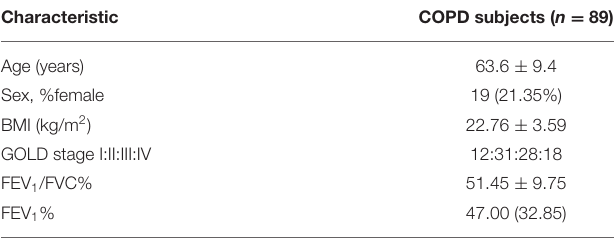
TABLE 1 | Patient Characteristics and PFT results in the COPD subjects.